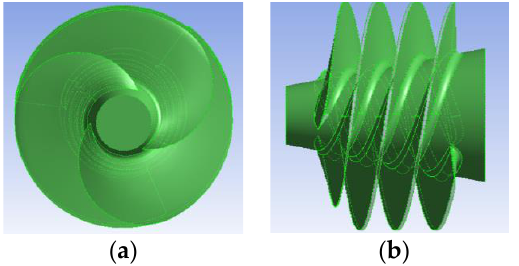
Figure 1. The model of three blades inducer. ( a ) Front view; ( b ) Side view.